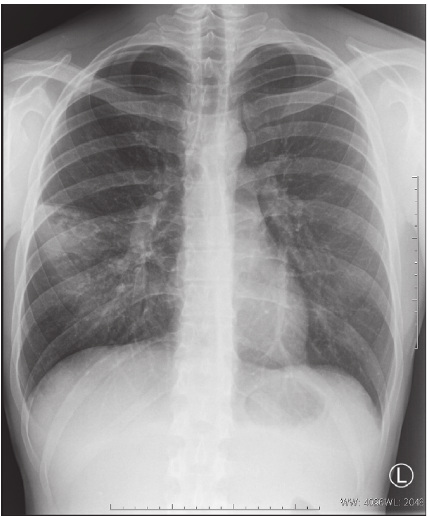
Figure 2: Diffuse consolidation in the lower lobe of the right lung (segment 6) consistent with pneumonia.